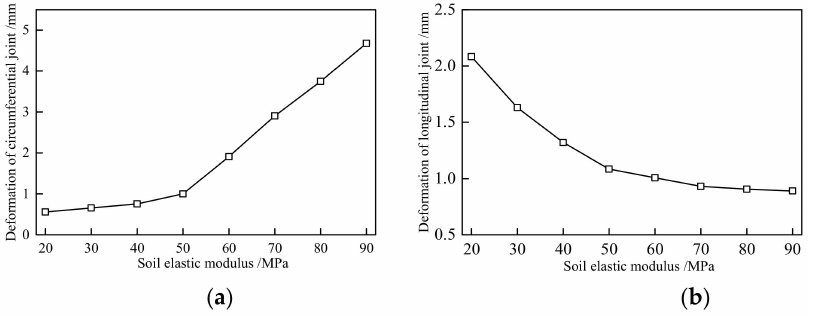
Figure 19. Effect of the elastic modulus of stratum on the segmental joint deformation: ( a ) normal faulting condition and ( b ) reverse faulting